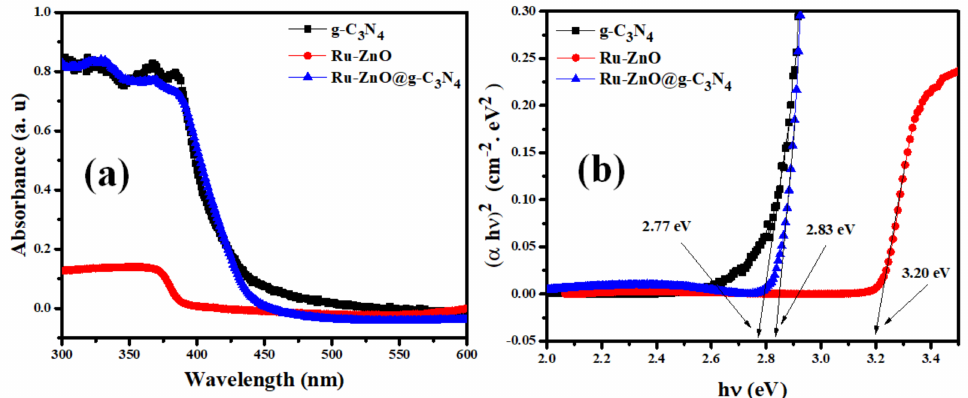
Figure 5. UV-Vis spectra ( a ) and bandgaps ( b ) of g-C 3 N 4 , Ru-ZnO, and Ru-ZnO @g-C 3 N 4 nanocomposite. By combining Ru-ZnO with g-C 3 N 4 , the band gap of the Ru-ZnO composite has been significantly reduced. Similar studies of heterojunctions generated by coupling g-C 3 N 4 to semiconductors with a large bandgap to form SrTiO 3 @g-C 3 N 4 [44], MgO@g-C 3 N 4 [45],